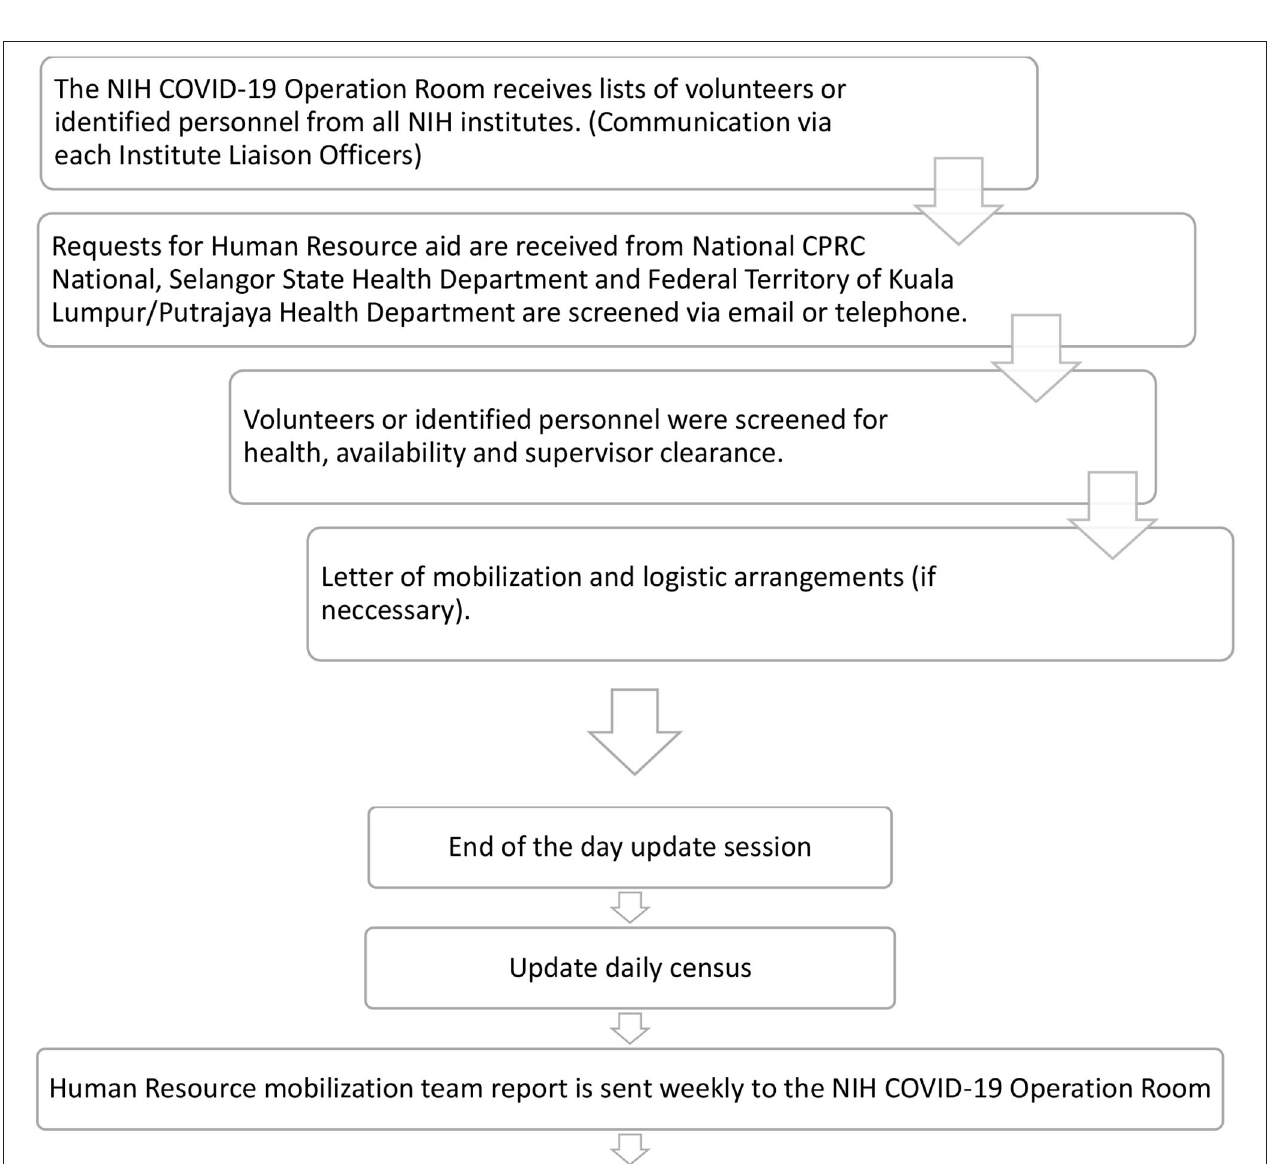
FIGURE 2 | The workflow for the COVID-19 operation room NIH mobilization